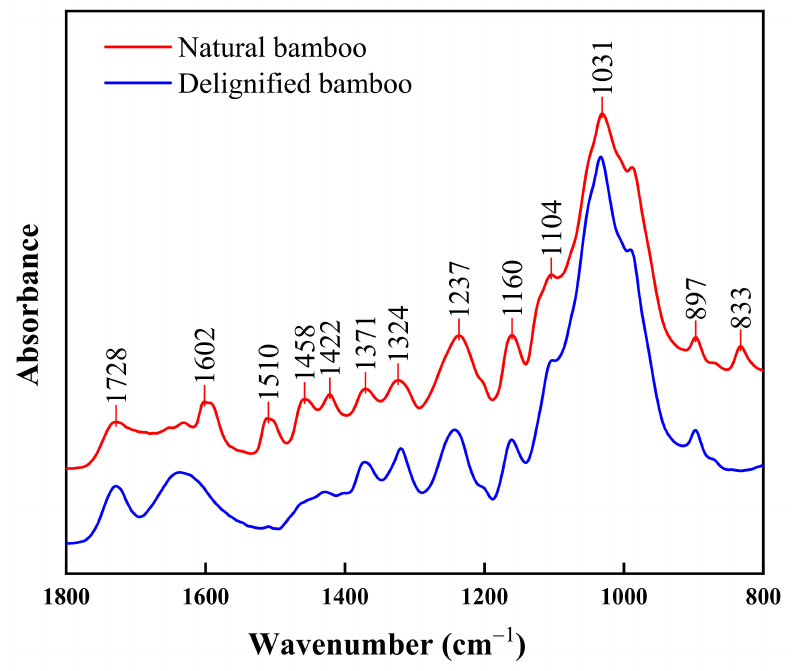
Figure 2. Fourier transform infrared (FTIR) spectra of NB and